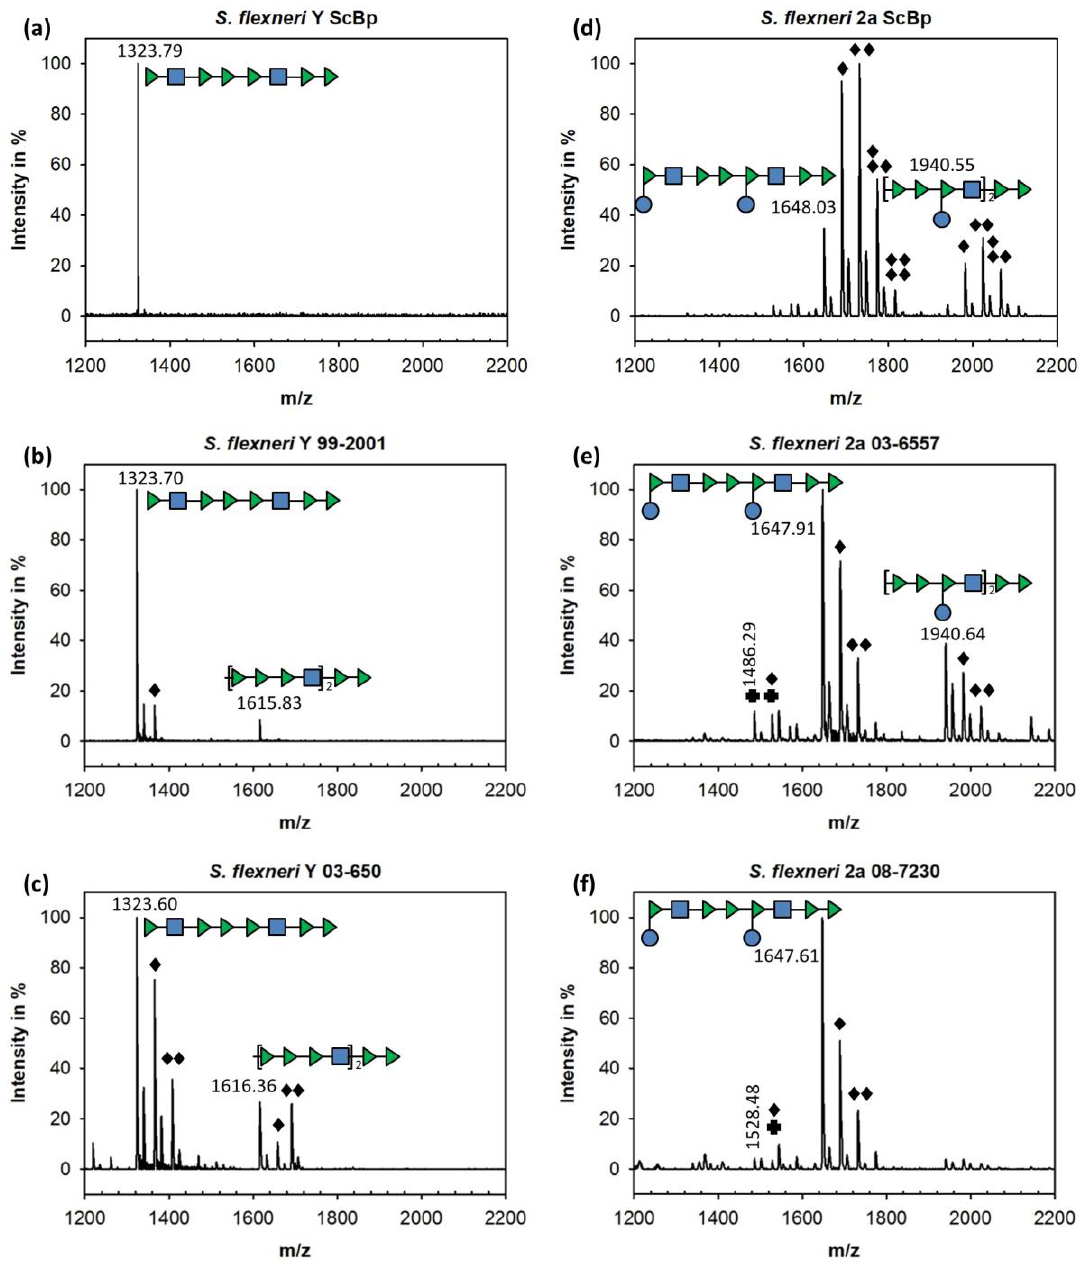
Figure 2. MALDI-TOF MS analysis of oligosaccharides enzymatically released from S. flexneri O-antigen (overnight at room temperature) by Sf6TSP wt and isolated by size exclusion chromatography (see Figures S1–S6 and Tables S1–S6). ( a , d ) S. flexneri Y and 2a probes from ScBp. ( b , c , e , f ) S. flexneri isolates from the Wernigerode collection. Oligosaccharide structures are given with monosaccharides in SNFG representation [41] (Rha p : green triangle, Glc p NAc: blue square, Glc p : blue circle). Modifications by O-acetylation (black diamonds), and monoglucosylated products (black crosses) are indicated.